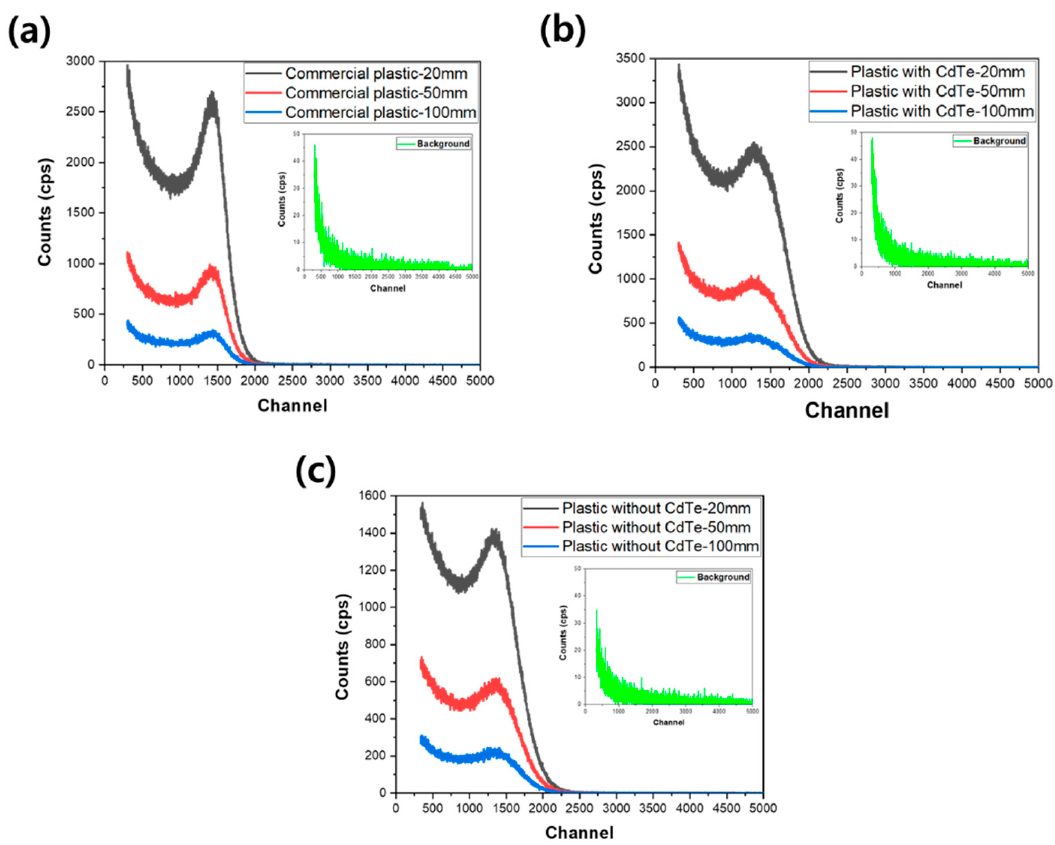
Figure 7. Normalized energy spectrum by distance. ( a ) Commercial plastic scintillator. ( b ) Plastic scintillator with CdTe. ( c ) Plastic scintillator without CdTe.